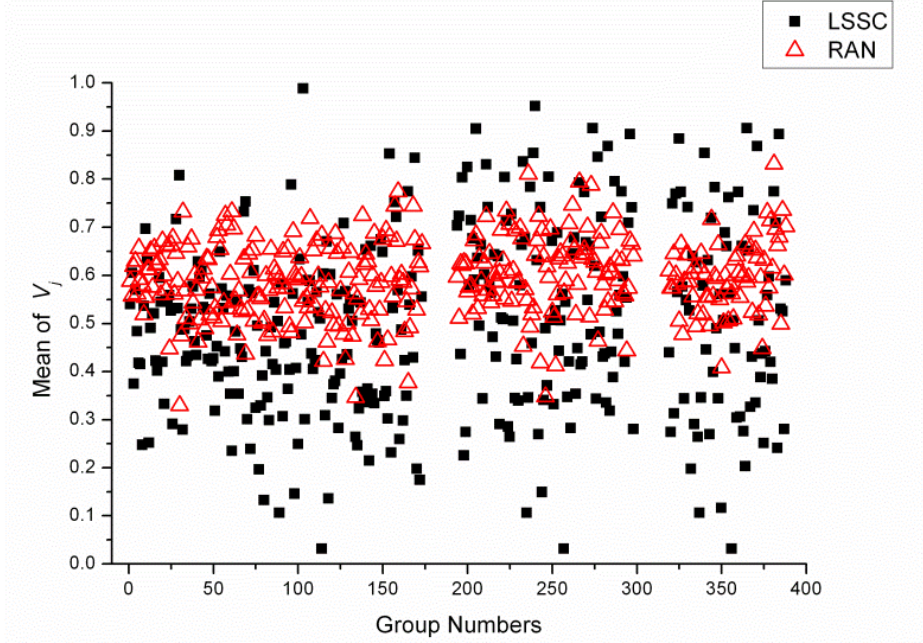
Figure 3. Range of mean (cid:1848) values in each cluster in LSSC datasets (from 0.032 to 0.989) (cid:3037) was wider than the range in random datasets (form 0.347 to 0.871). (Group numbers: 1~173 belonged to the LSSC30 or RAN30 datasets, 194~298 belonged to the LSSC60 or RAN60 datasets, 319~388 belonged to the LSSC90 or RAN90 datasets; Solid black square: mean (cid:1848) in each cluster in LSSC datasets, hollow red triangle: mean of (cid:1848) (cid:3037) group in random